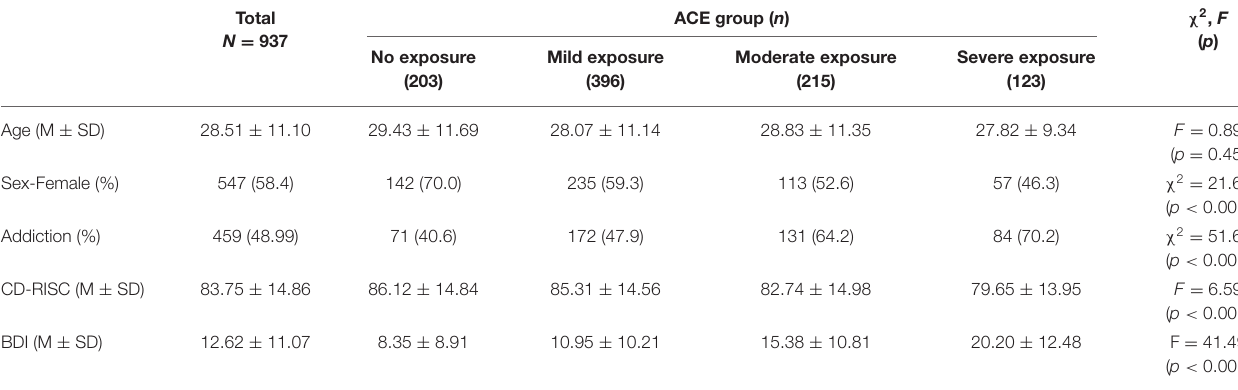
TABLE 1 | Characteristics of sample and ACE group comparisons for all